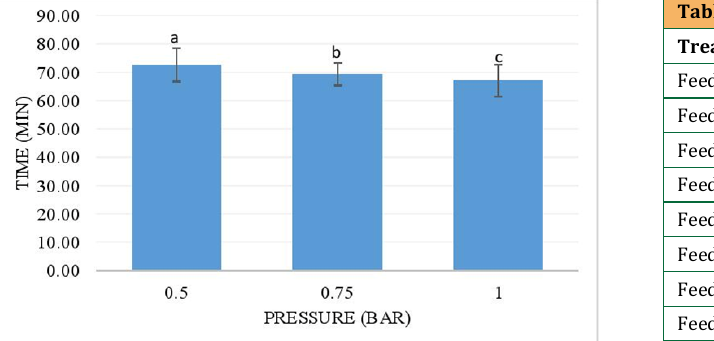
Figure 6: Effect of pressure on composting time